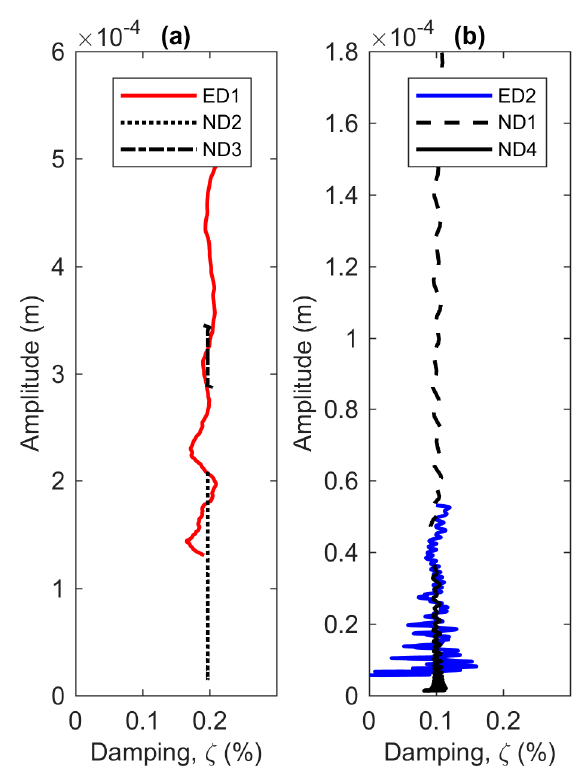
Figure 8. Damping curves of ( a ) the first and ( b ) second modes.